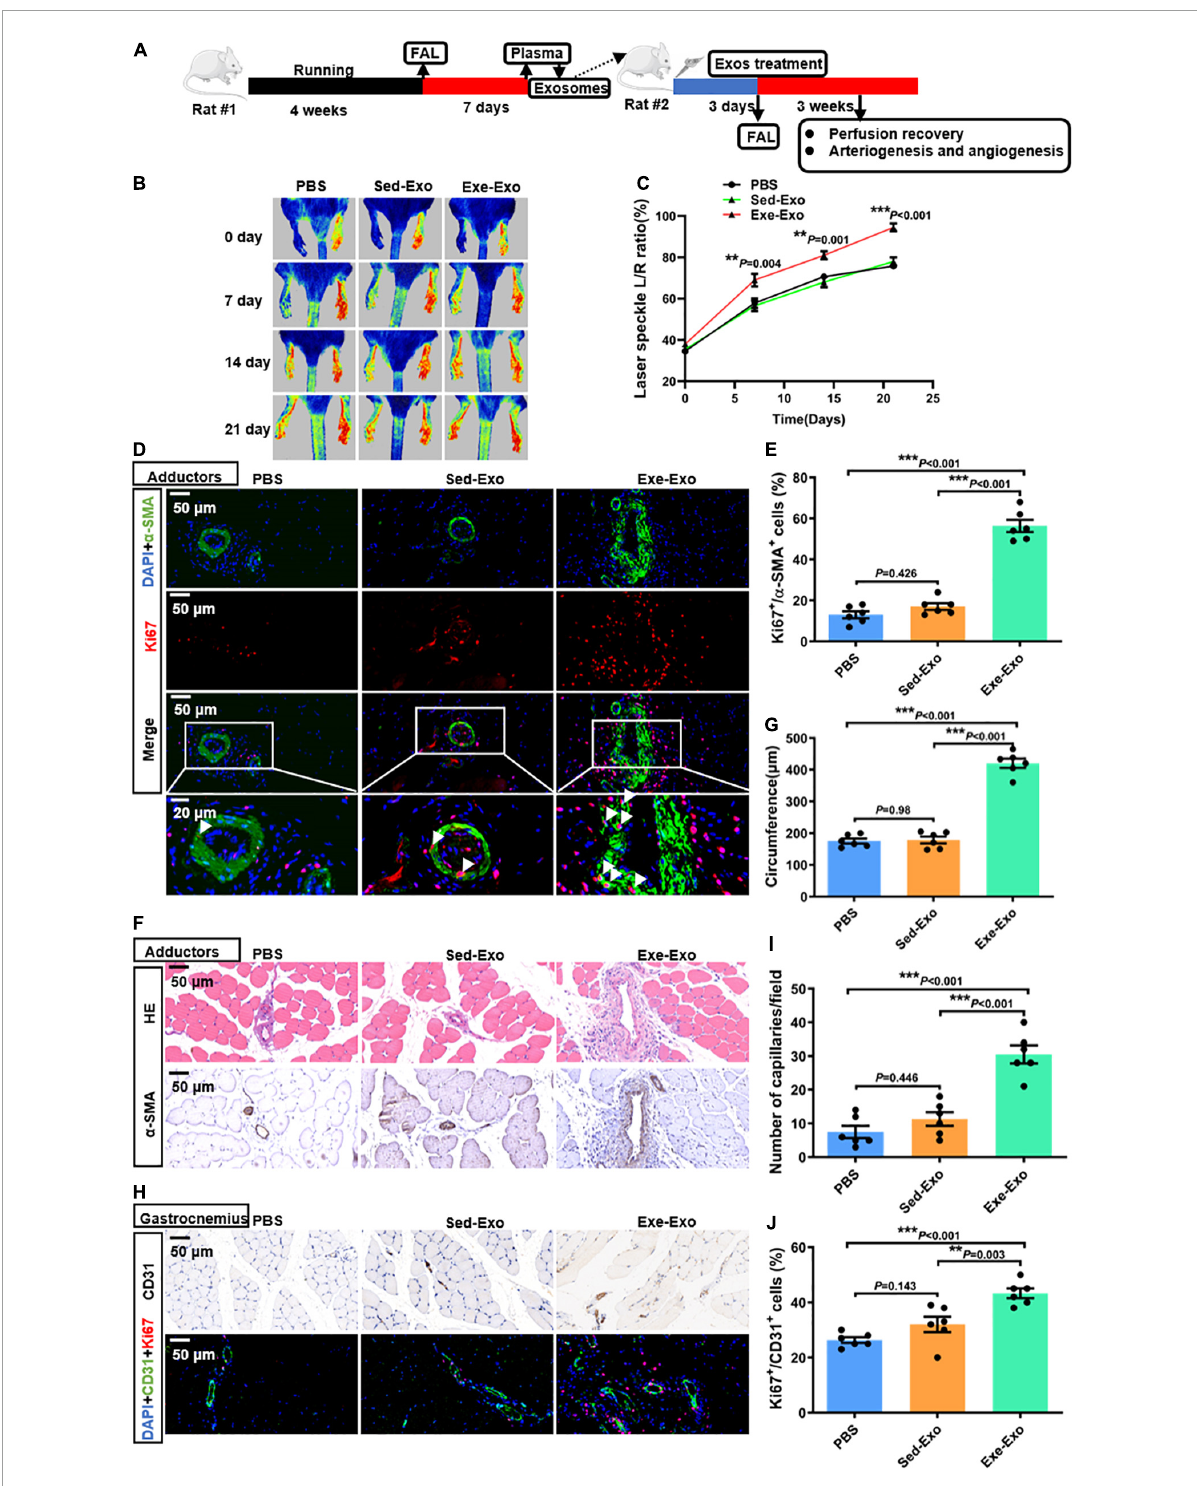
FIGURE2 Local muscle delivery of exercise-derived circulating exosomes promoted arteriogenesis, angiogenesis and perfusion recovery. (A) Rats were subjected to 4 weeks of treadmill training or kept as sedentary controls followed by FAL surgery. Then, equivalent quantities of exosomes (1 mg, mixed with pluronic gel) isolated from the plasma of rats (Exe or Sed) 7 days post-FAL were injected into the left adductor muscles of the second batch of healthy adult rats. Subsequently, all the second batch rats were exposed to FAL surgery, and perfusion recovery, and arteriogenesis and angiogenesis were measured. (B,C) Representative laser speckle perfusion images (B) and quantitative analysis (C) of the ratios of left to right (L/R) hindlimb perfusion among PBS-, Sed-Exo- and Exe-Exo- treated rats at the indicated times after FAL.